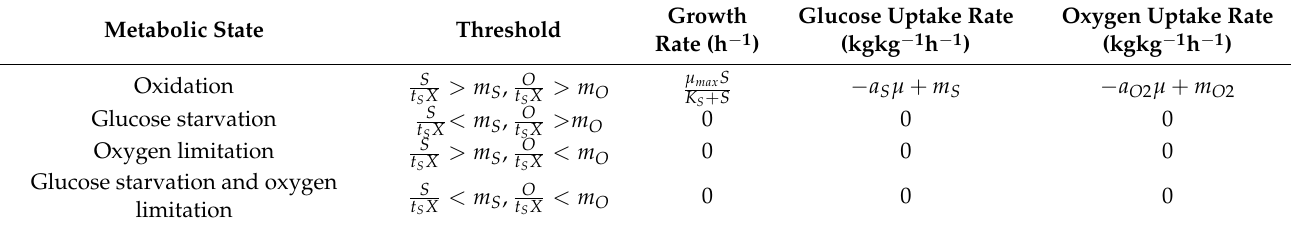
Table 1. Definition of different metabolic states that can be encountered in the compartmental model alongside the description of microbial kinetics for each metabolic